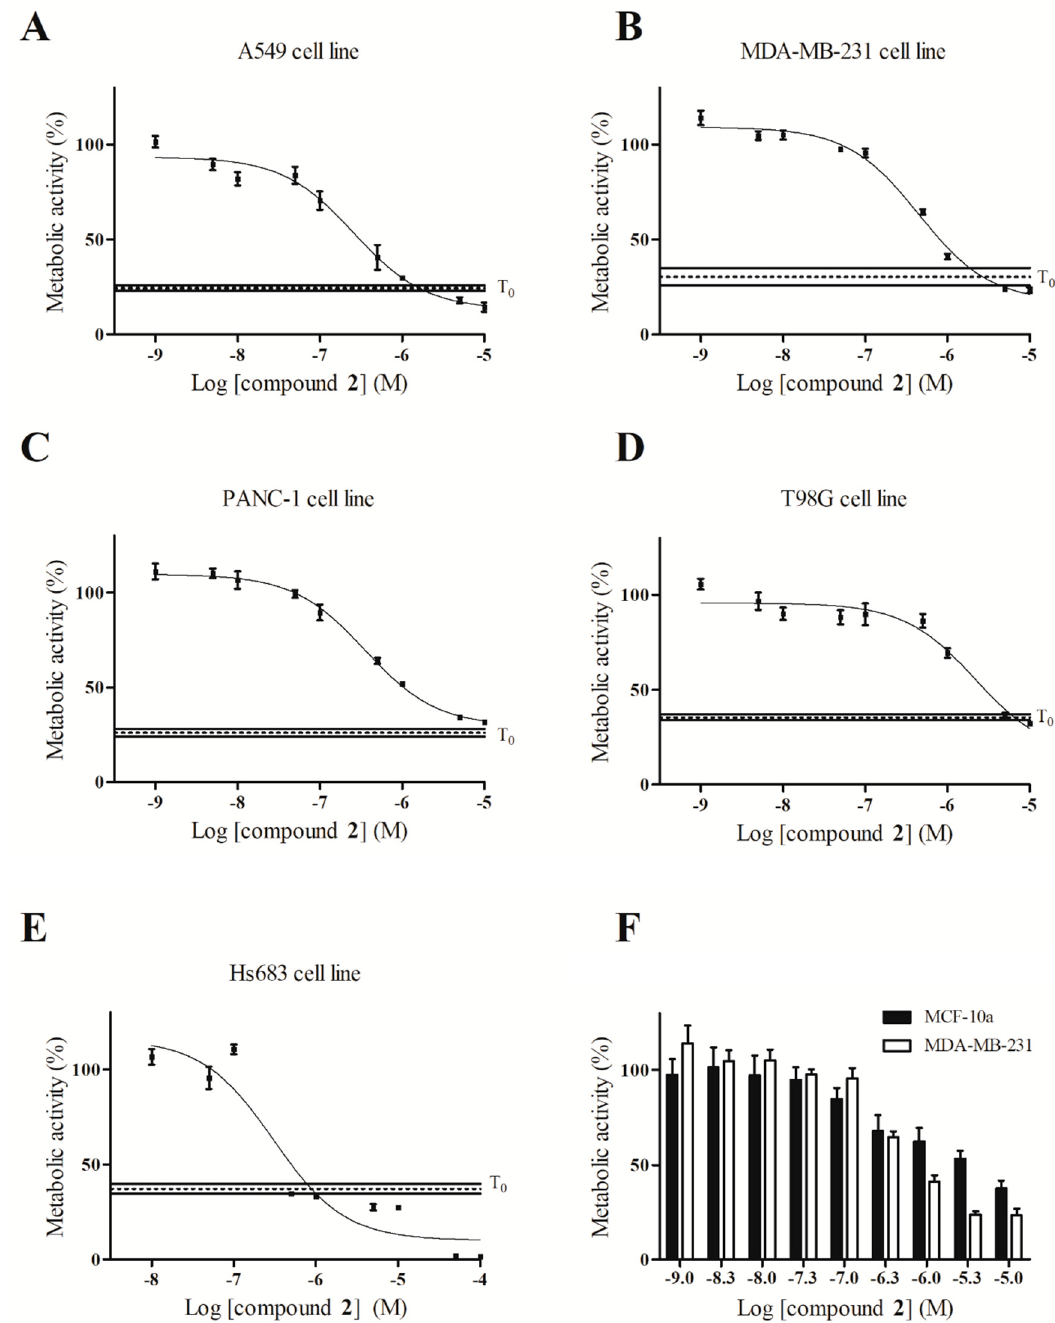
Figure 5. ( A – E ): IC 50 graphs of compound 2 on five different cell lines. Plain horizontal lines (T 0 ) represent metabolic activity range just before treatment with compound 2 (metabolic activity at IC 50 concentration falling in this range means cytostatic behavior of compound 2 ). ( F ): Activity of compound 2 on normal (MCF-10a) and breast cancer (MDA-MB-231) cell lines. Table 2. Determination coefficient, IC 50 values, confidence interval and cytostatic behavior at IC 50 . Cell Lines